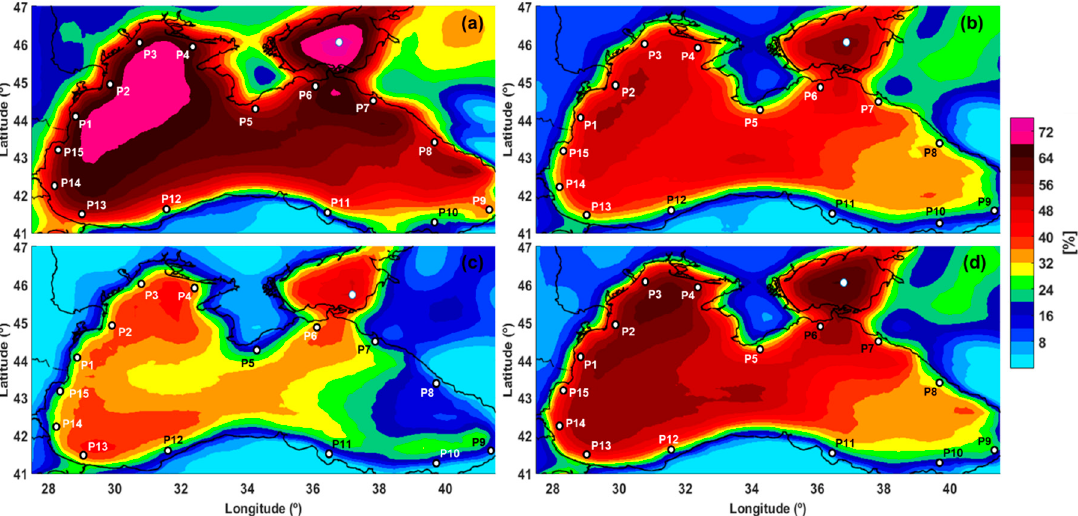
Figure 6. Seasonal distribution of the U 10 parameter higher than 6 m/s considering the entire 30-year period (1987–2016) of NCEP wind data, where: ( a ) winter; ( b ) spring; ( c ) summer; ( d ) autumn.